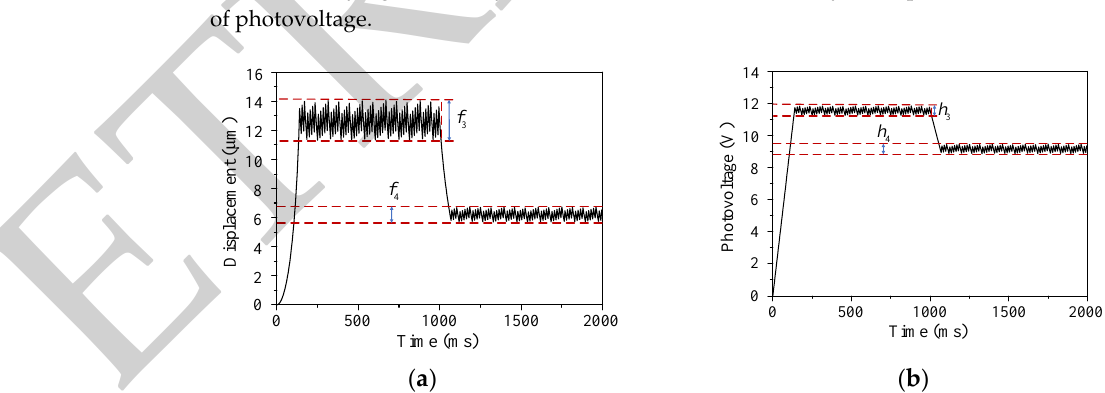
Figure 8. The closed-loop control simulation curve of photovoltaic-electrostatic hybrid actuator illuminated by light intensity of 40 mW/cm 2 . ( a ) Time history of displacement. ( b ) Time history of photovoltage.